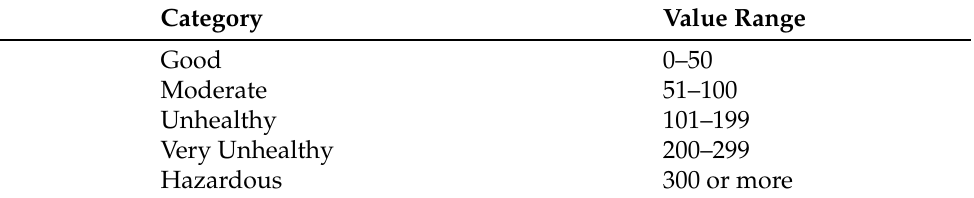
Table 3. Air Quality